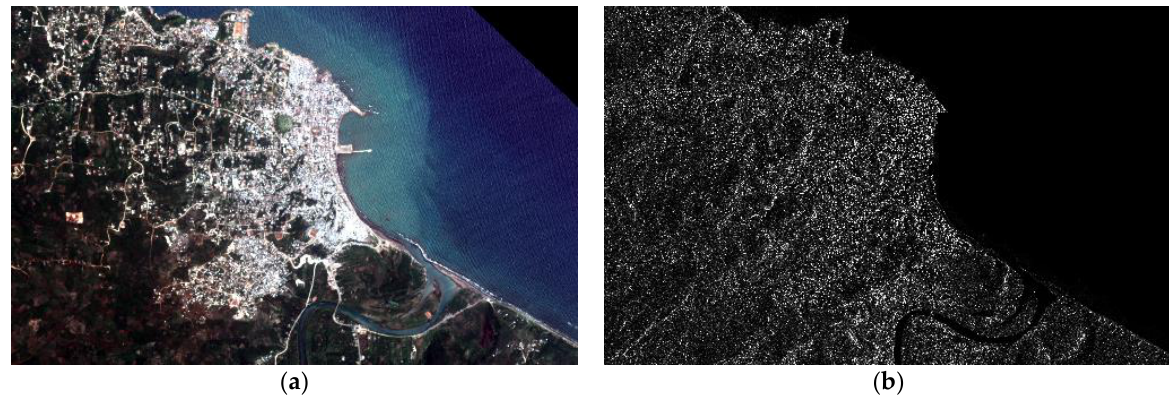
Figure 4. “Jérémie 2019” dataset: ( a ) RGB true-color composition of the multispectral Pléiades acquisition (image © CNES 2019, distribution Airbus DS); ( b ) Enhanced Spotlight SAR acquisition (COSMO-SkyMed Product © ASI—Italian Space Agency—2019. All rights reserved.).